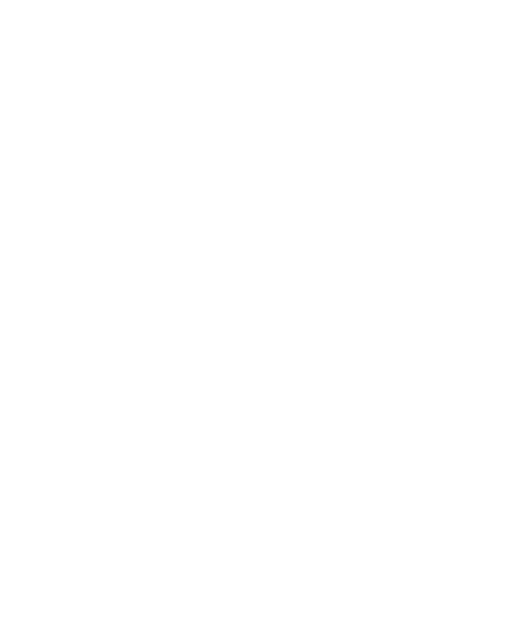
Table 1. Resulting correction factors from empirical parameter tuning.